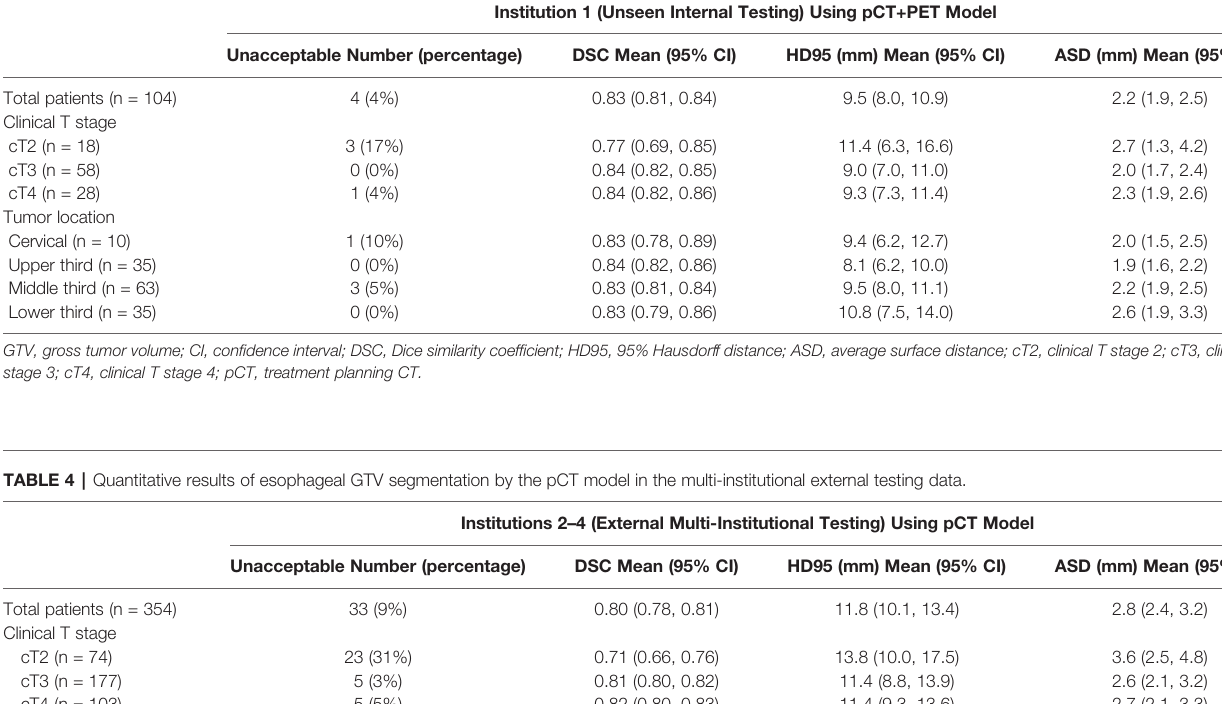
TABLE 3 | Quantitative results of esophageal GTV segmentation by the pCT+PET model in the unseen internal testing data. Institution 1 (Unseen Internal Testing) Using pCT+PET Model